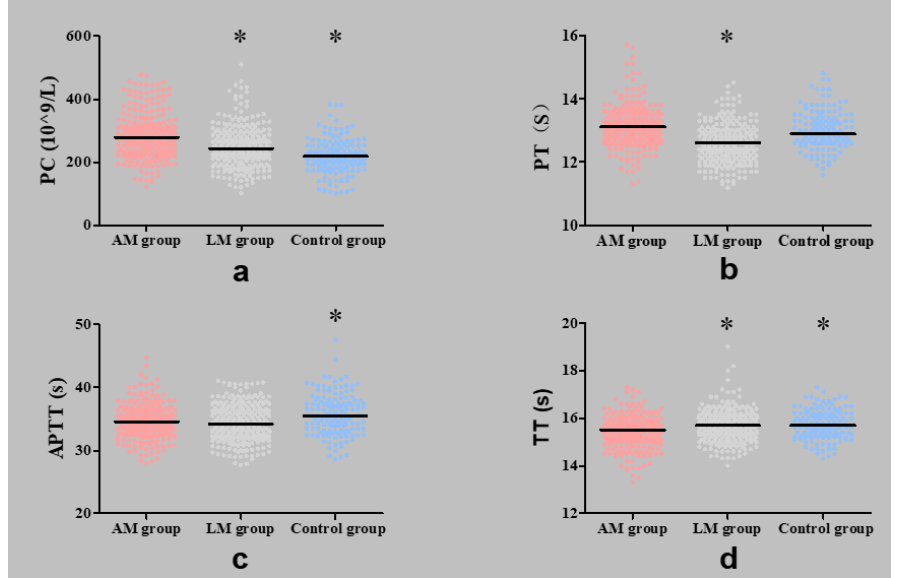
Figure 2. Comparisons of coagulation parameters between groups (median and range). ( a ) Com- parison of platelet count (PC) between groups; ( b ) Comparison of plasm a prothrombin time (PT) between groups; ( c ) Comparison of activated partial prothrombin time (APTT) between groups; ( d ) Comparison of thrombin time (TT) between groups. *, p < 0.025 (compared with the AM group).